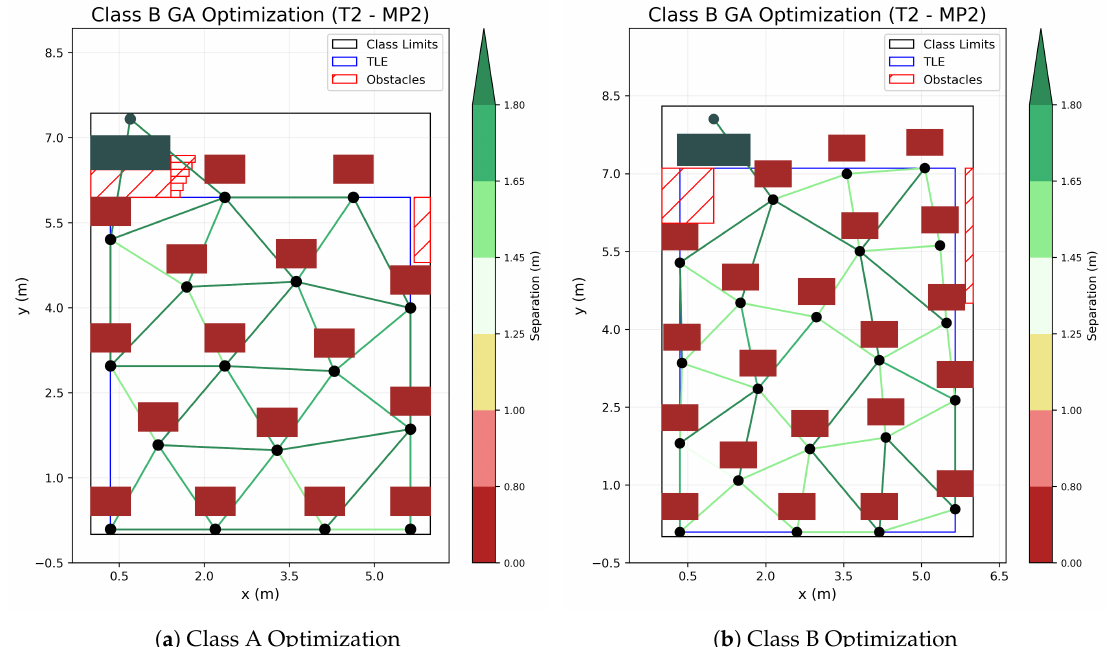
Figure 5. Table distributions obtained for each scenario. The application of each optimization is based on the configuration proposed in Table